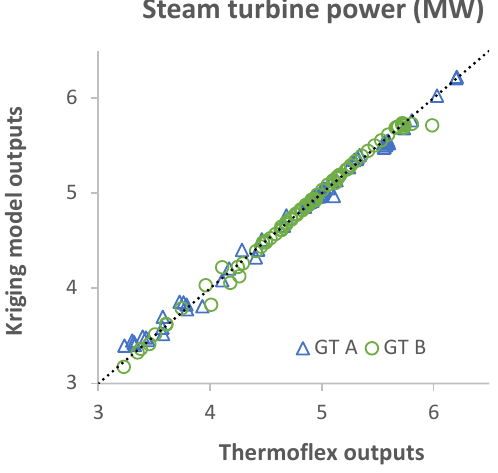
Figure A6. Parity plot of the steam turbine power output for the off-design model validation.